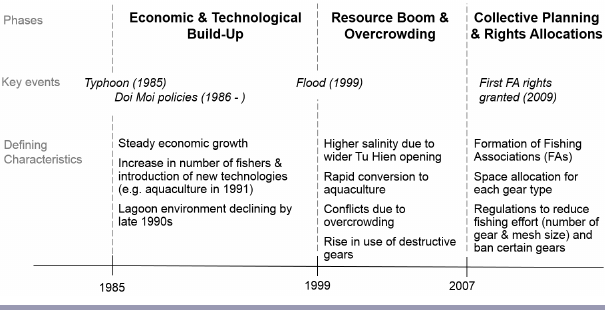
Fig. 2 . Phases of social-ecological change in the Cau Hai